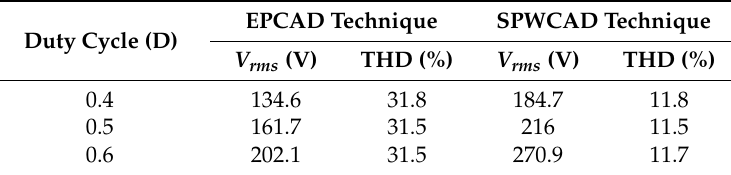
Table 8. Experimental comparison of ( V rms ) and %THD.